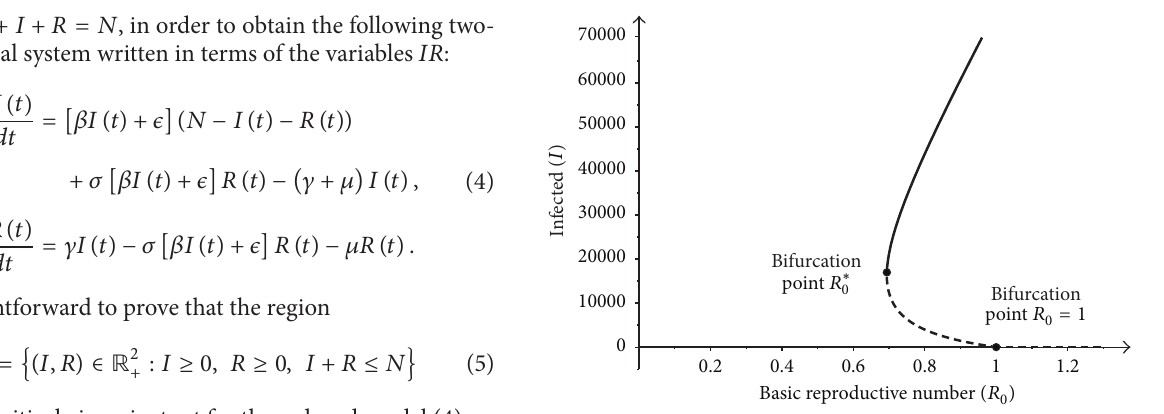
Figure 2: Schematic representation of the bifurcation diagram of system (4) for the case 𝜖 = 0 . Here is shown the variable 𝐼 as a function to the parameter 𝑅 0